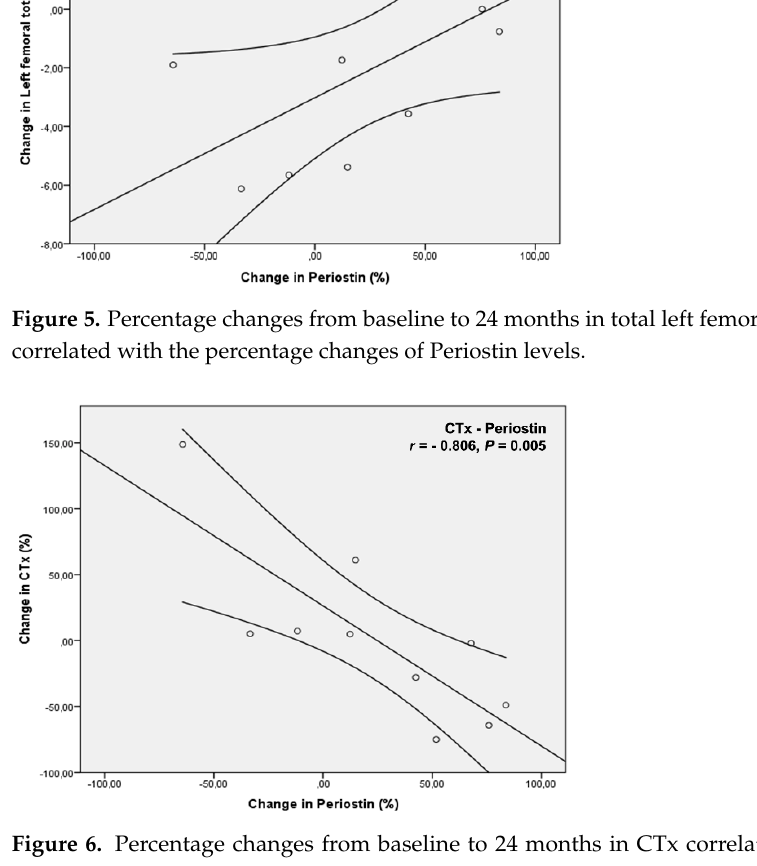
Figure 5. Percentage changes from baseline to 24 months in total left femoral BMD were positively correlated with the percentage changes of Periostin levels.